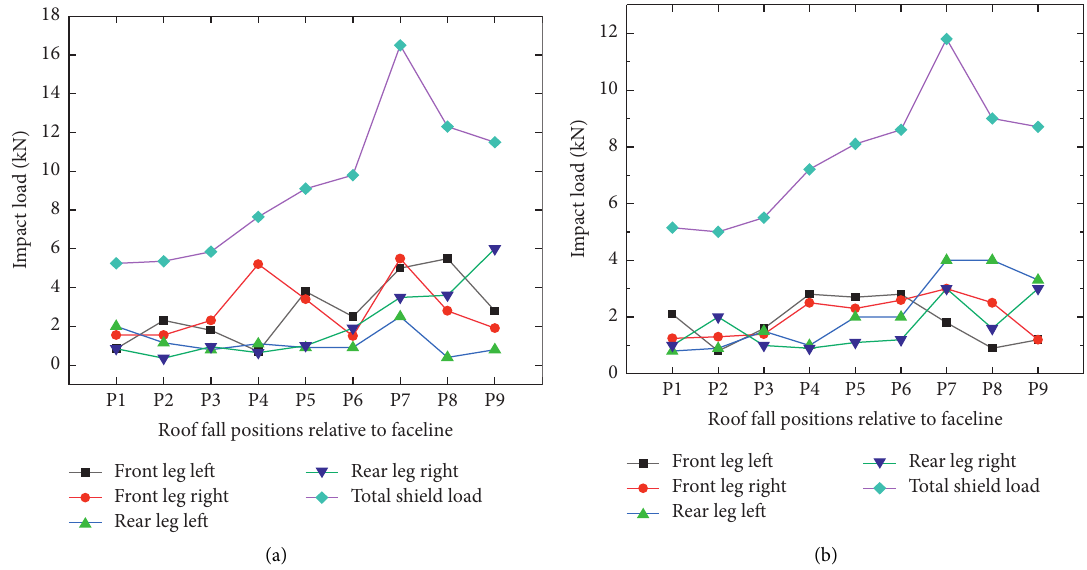
Figure 6: Distribution of dynamic load on shield legs at different roof fall positions: (a) large-cutting-height model; (b) top-coal-caving model.